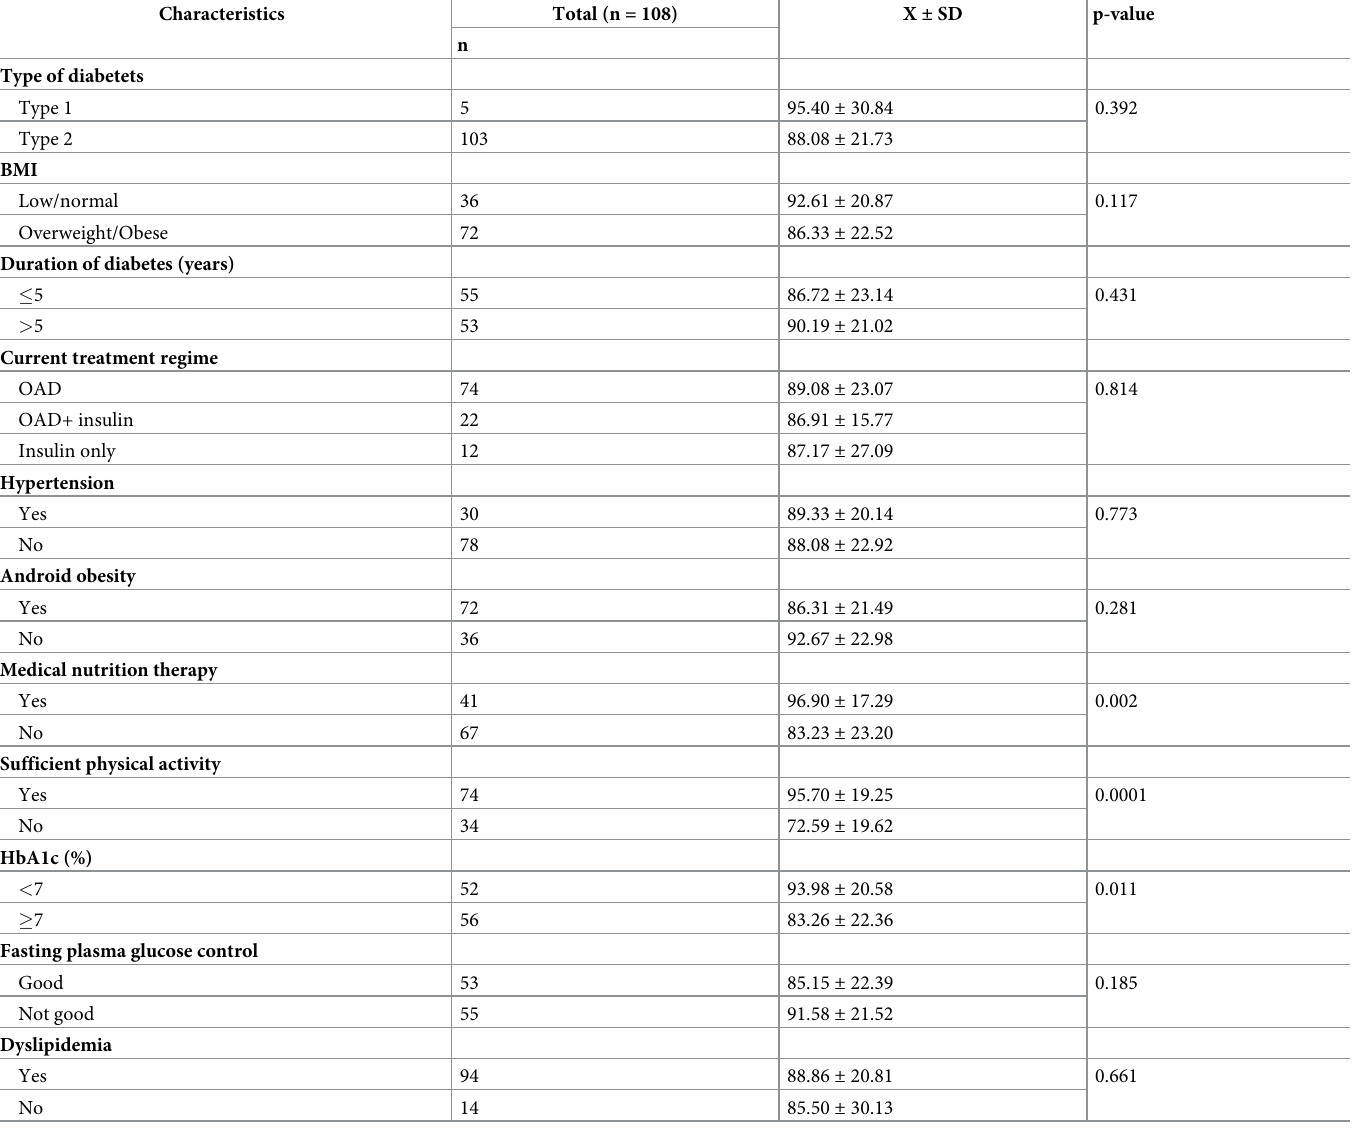
Table 4. Clinical characteristics and the mean total DSMI scores by clinical